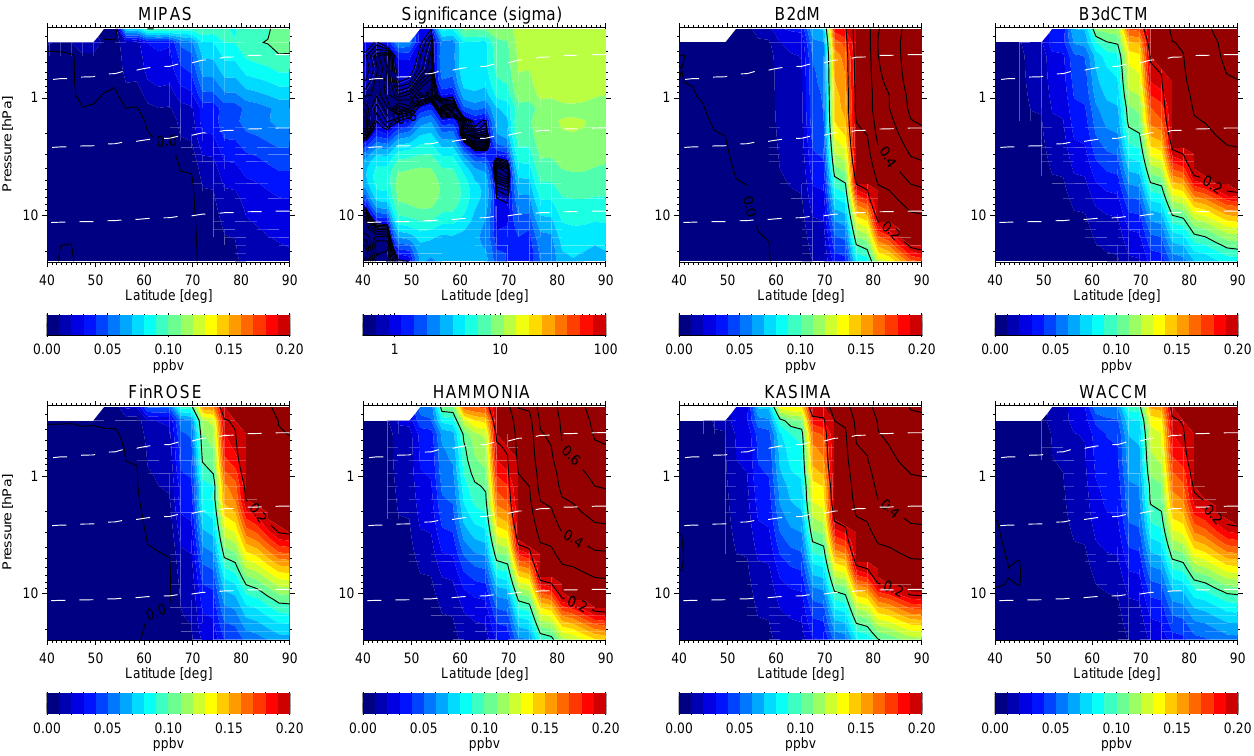
Fig. 31. Zonal mean H 2 O 2 changes with respect to 26 October averaged over the period 28 October–4 November in MIPAS observations and model simulations. Solid contour lines reflect 0.1ppbv steps. The significance of observed H 2 O 2 changes (in units of σ ) is shown in the upper second panel (from the left).